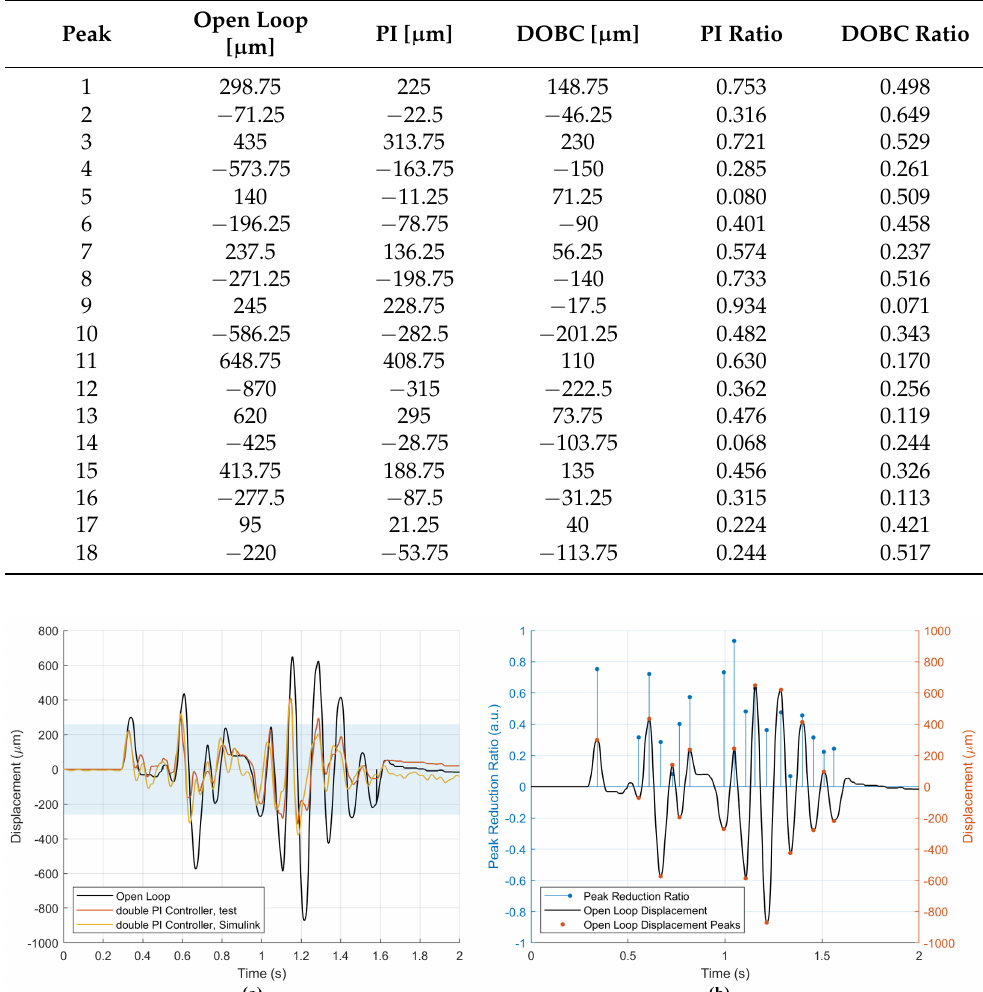
Table 2. Displacement peaks value and the peak reduction ratio of Open Loop, PI controller, and dis- turbance observer-based controller.